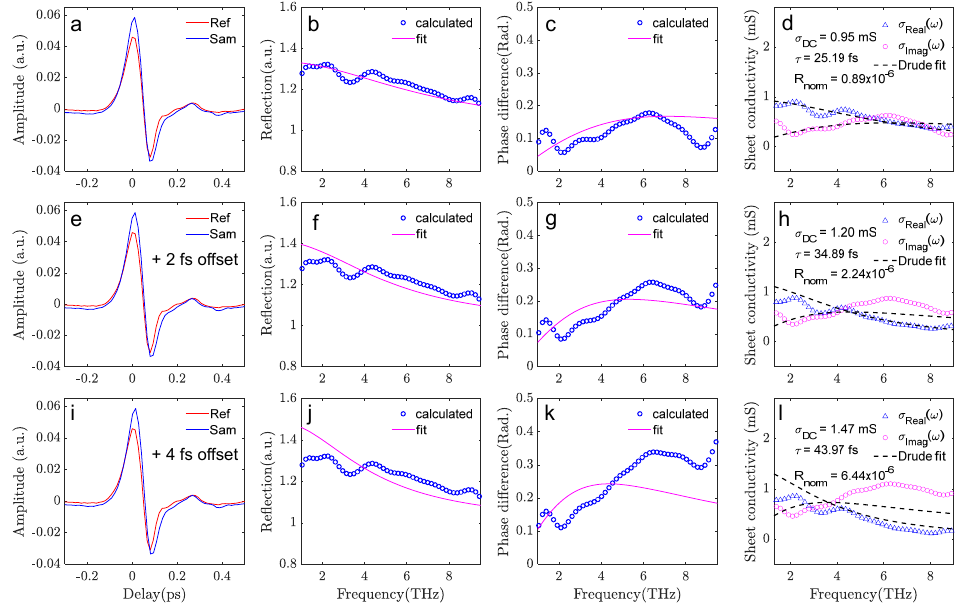
Figure 5. Phase offset correction of the reflection-mode THz-TDS data analysis. ( a–d ) With optimum offset correction, the extracted conductance spectra match the best with the Drude model. The calculated reflection and phase difference curves also match best with the fit. ( e–h ) With 2 fs extra phase offset, the extracted parameters show significant deviation from the Drude model fits. ( i–l ) With 4 fs extra offset, a Drude fit is impossible in the broad frequency range.